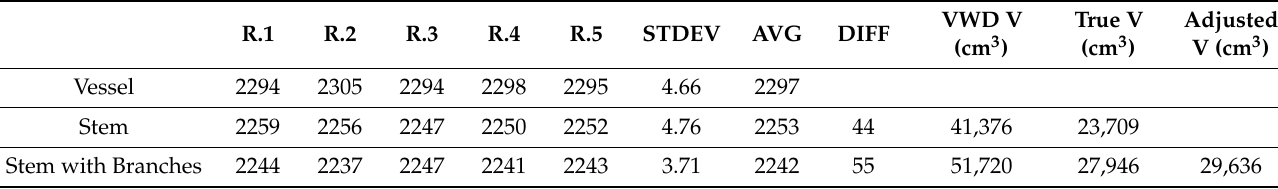
Table 3. VWD estimation for artificial stems. Vessel refers to the vast vessel (bottom length = 120, bottom width = 60, height = 300) in Figure 8 (right). Stem refers to the resampled point cloud in Figure 2 (left). Branch refers to the resampled point cloud in Figure 2 (right). R.1 to R.5 refers to the five repeated VWD processes. STDEV refers to the standard deviation; AVG refers to the average value of R.1 to R.5; DIFF refers to the replacement number of VWMs comparing with the actual filing number of vast vessel; true V refers to the mesh volume of tree models; VWD V refers to the V derived from VWD process; adjusted V refers to the final result of VWD